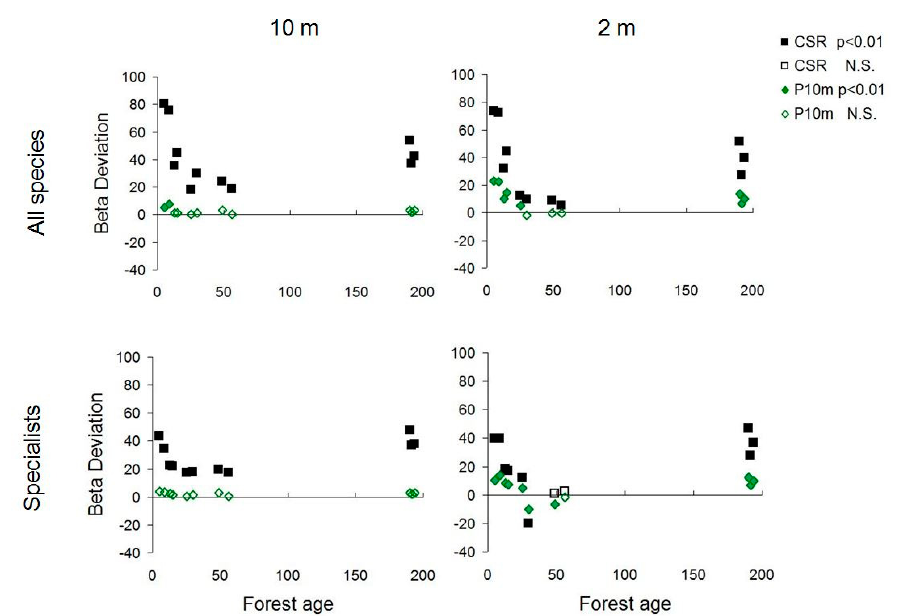
Figure 4. Null model ‐ based beta diversity trends (Beta deviation of Bray–Curtis Dissimilarity) along the chronosequence. CSR = null model based on Complete Spatial Randomizations, P10m = Patch model randomization with 10m diameter.